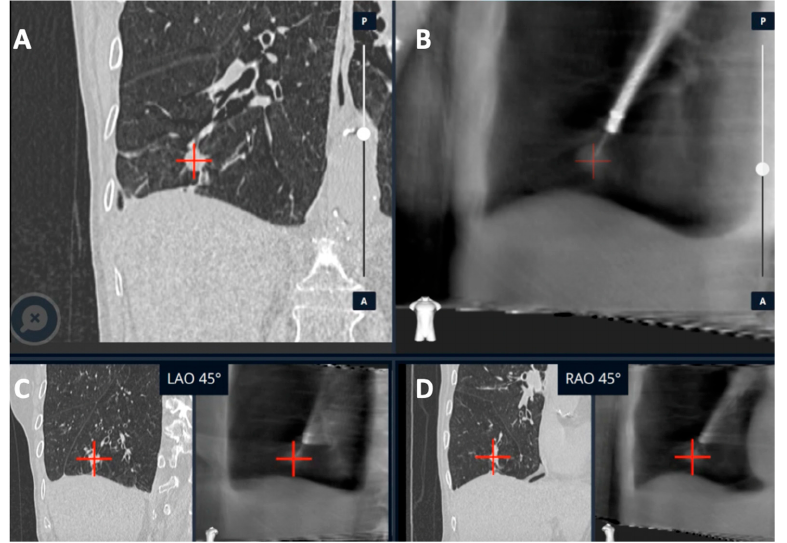
Figure 4. LungVision’s C-arm-based tomosynthesis (CABT) imaging. ( A ) Preoperative CT with lesion. ( B – D ) Tool in lesion confirmation obtained in multiple planes.